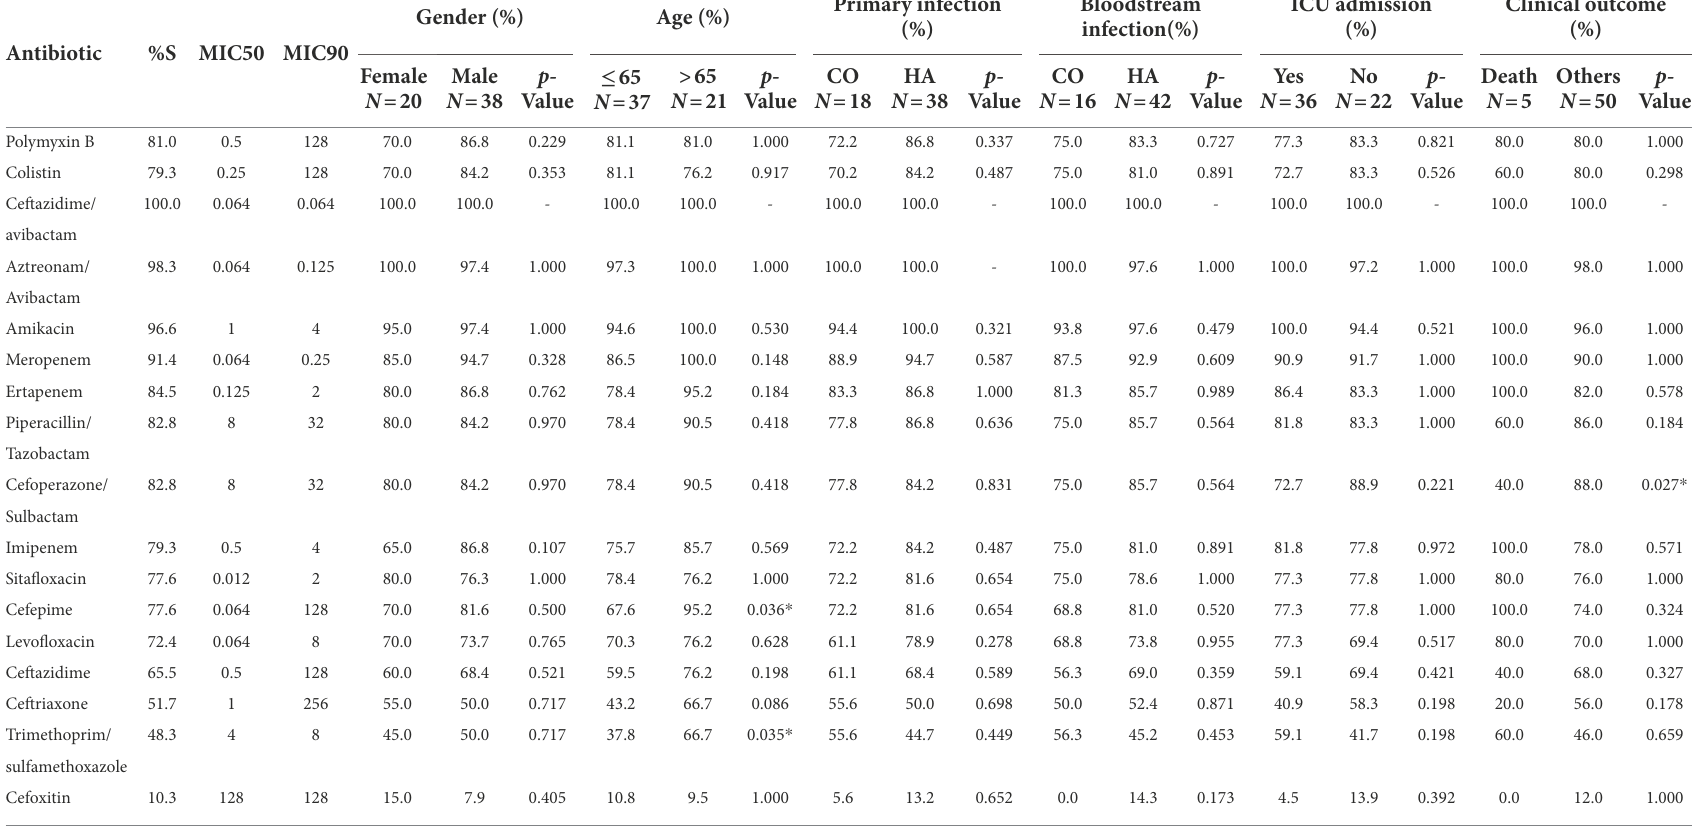
TABLE 5 Comparison of the antimicrobial susceptibility rates of E. cloacae isolates in clinical features.